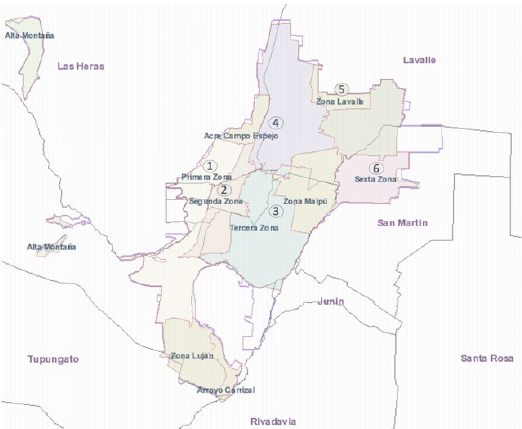
Figure 3. Map of the different irrigation zones in the Northern Oasis (Mendoza River).